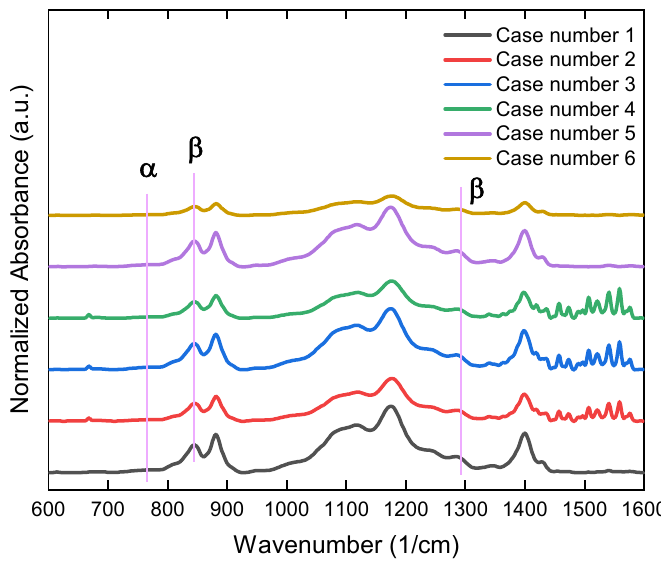
Figure 3. FTIR spectra of P(VDF-TrFE) nanofibers.